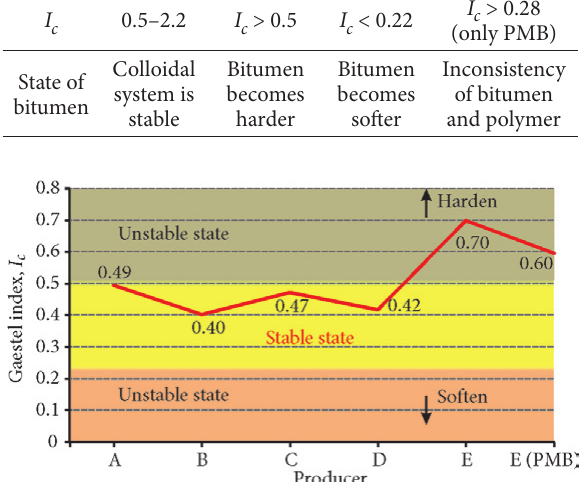
fig. 2. Bitumen colloidal